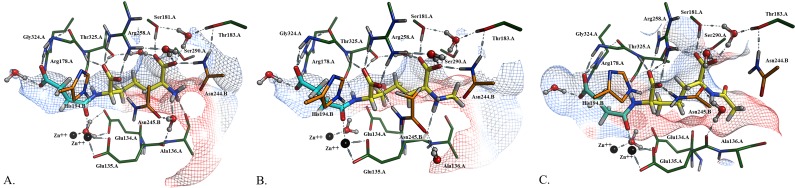
Minimized substrate analogs docked and modeled in the HiDapE active site.The diaminopimelate moiety is depicted in yellow and the succinate in turquoise. A) Native substrate L,L-SDAP, B) N6-methyl-L,L-SDAP, and C) N6-acetyl-SDAP. The catalytic domain of Chain A is depicted in green, whereas the dimerization domain of Chain B is shown in orange.